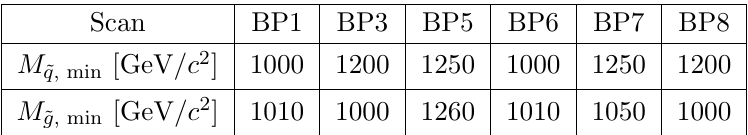
Table 6. Approximate lower bounds on the squark mass and corresponding gluino mass at 95% CL for a 3 GeV/ c 2